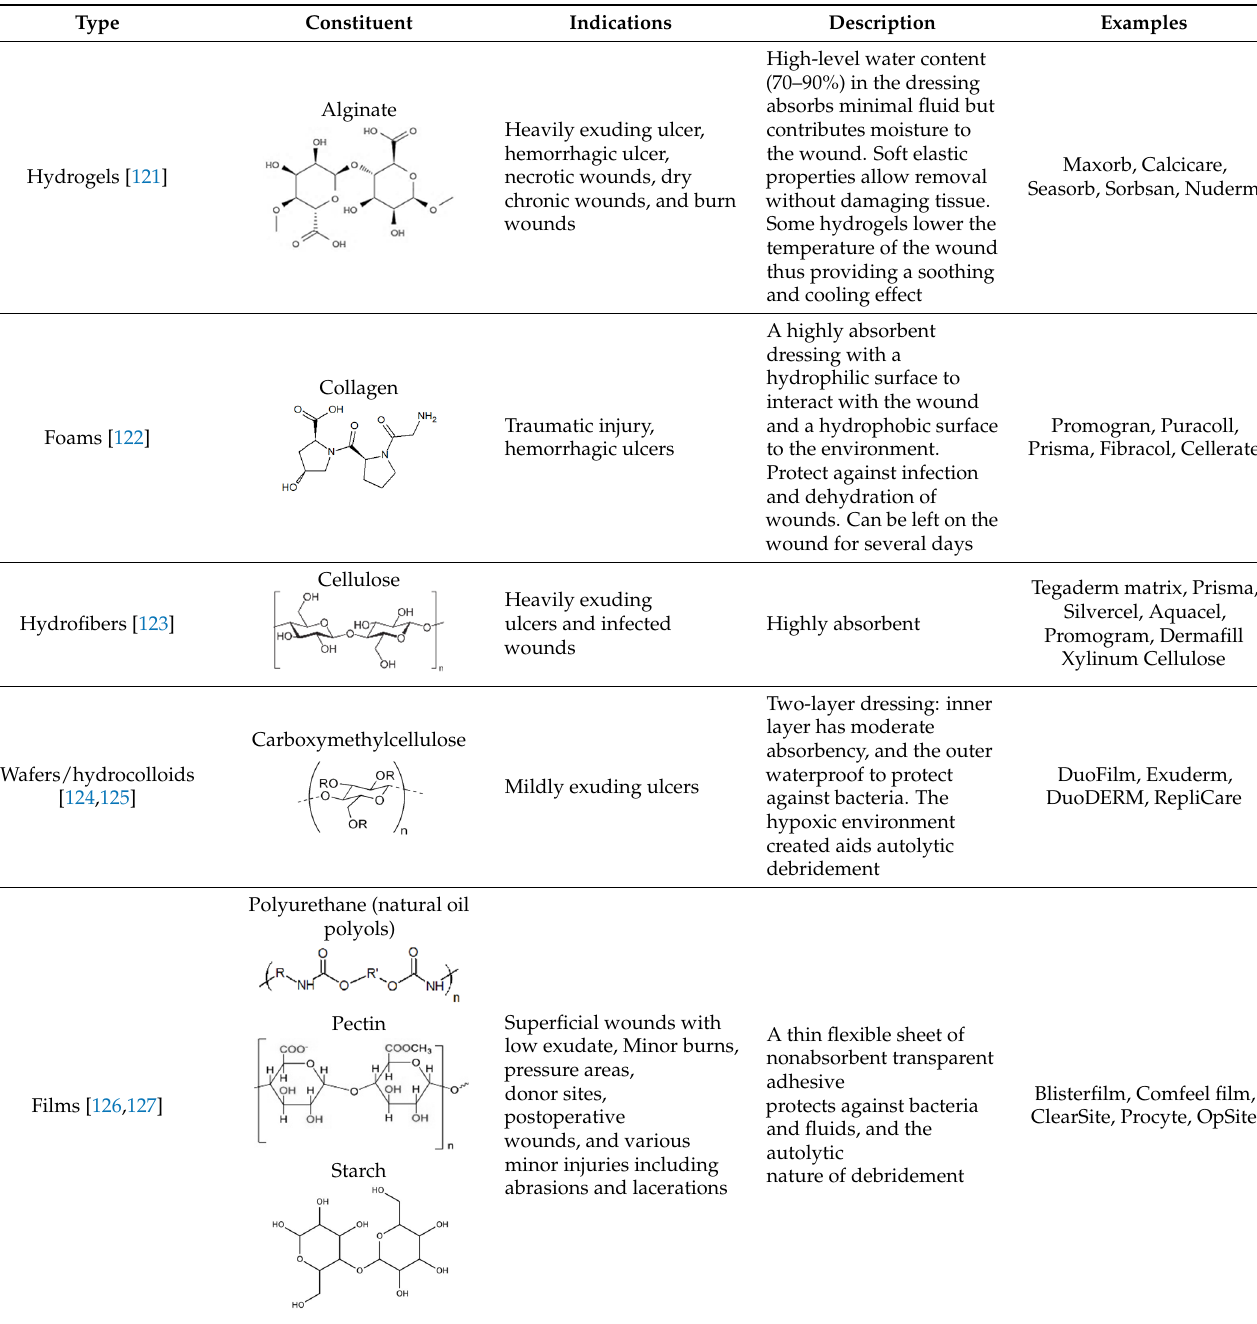
Table 4. Some examples of nature-based biomaterial dressings, demonstrating their effects in the clinical usage for wound healing.